Question: Name the type of graph shown.
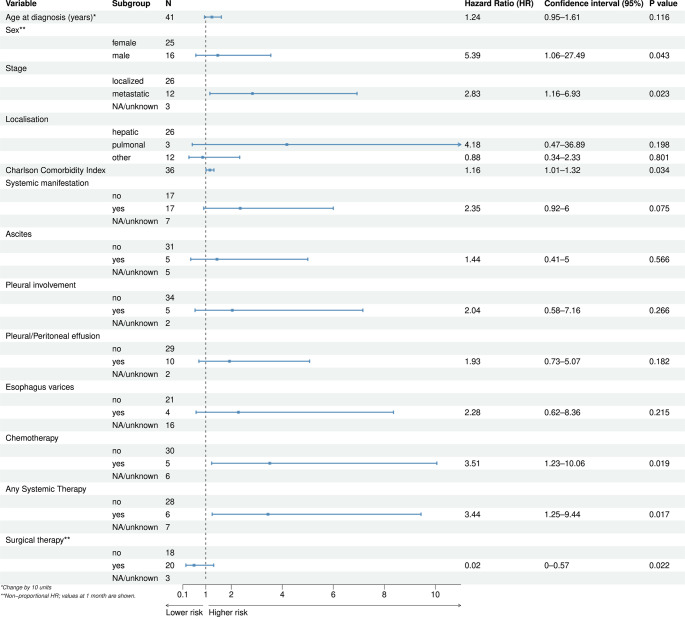
Answer: forest